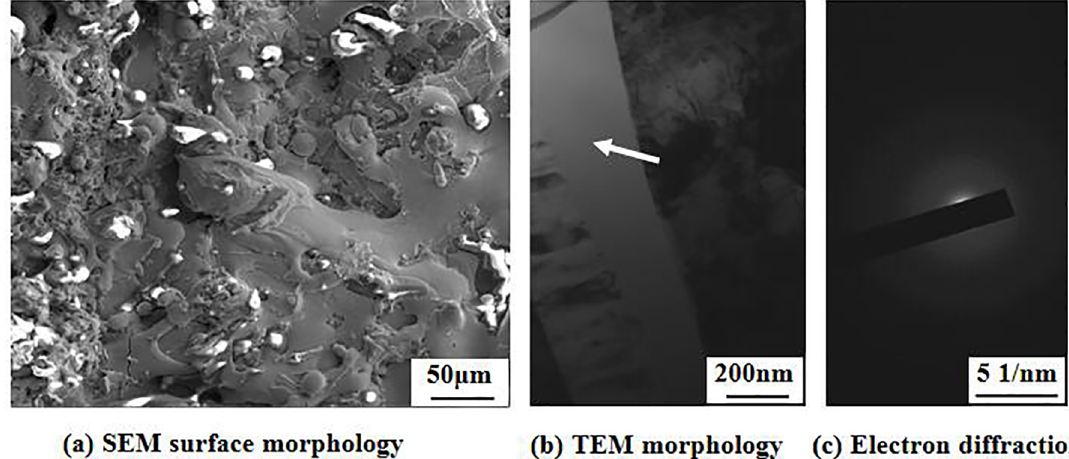
Figure 16. SEM surface morphology of the Ni-Al coatings (a) and TEM morphology(b) and selected-area electron diffraction